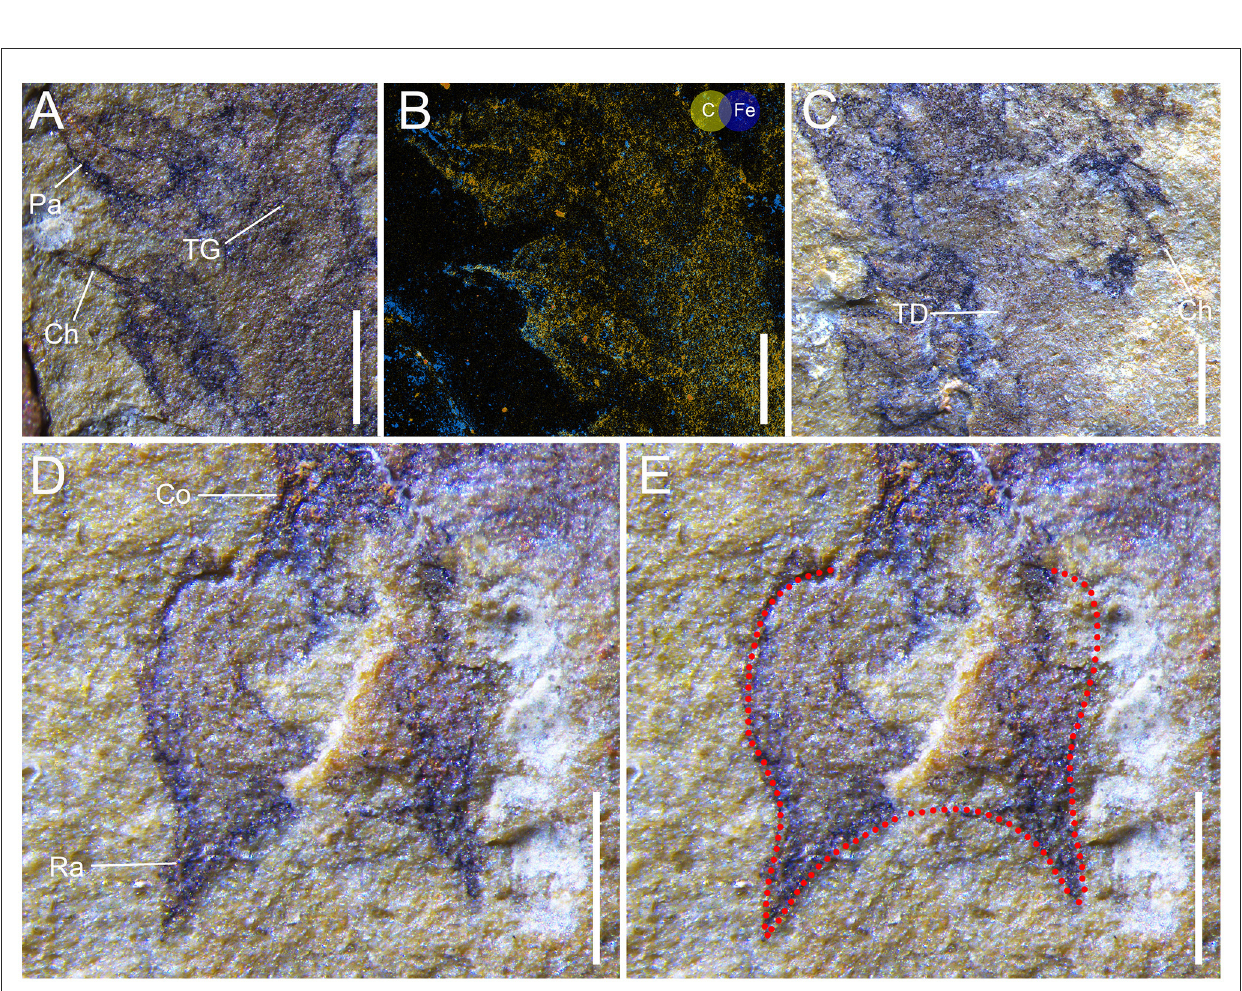
FIGURE4 Gaoloufangchaeta bifurcus gen. et sp. nov. (A) detail of Figure 2, position marked by frame b. (B) EDX map of (A) , the specimen was rotated anticlockwise slightly. (C) Detail of Figure 2, position marked by frame c. (D) Detail of Figure 2, position marked by frame d; the specimen was rotated clockwise a little to show the pygidium in upright orientation. (E) Detail of Figure 2, position marked by frame d; the red dotted line shows the profile of the pygidium. Ch, chaeta; Co, constriction; Pa, parapodium; Ra, ramus; TD, traces of decay; TG, traces of gut. The scale bars are 0.5mm.